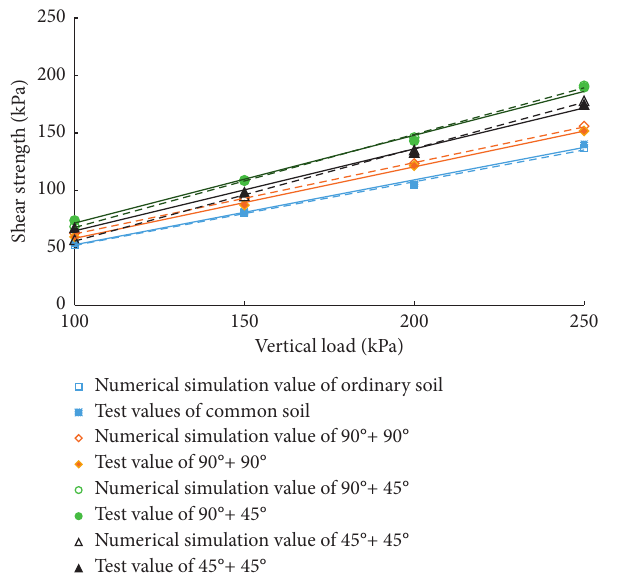
Figure 9: Relationship curve between shear strength and vertical load. Table 4: Incremental cohesion values at various angles. Angle ( ° )